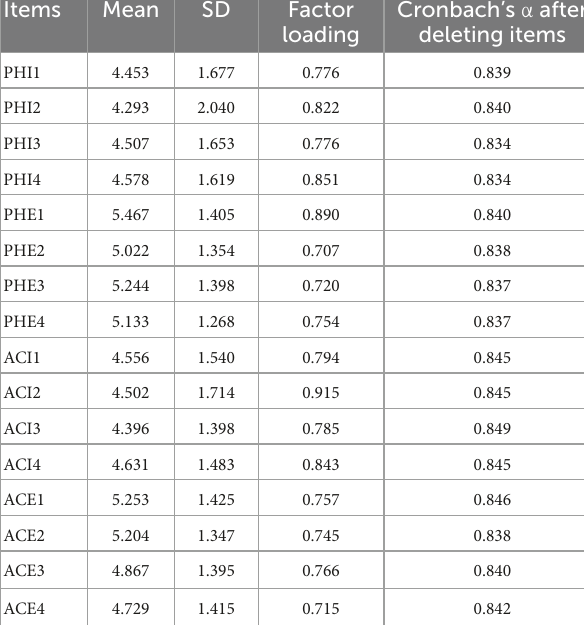
TABLE 2 Results of exploratory factor analysis ( n =